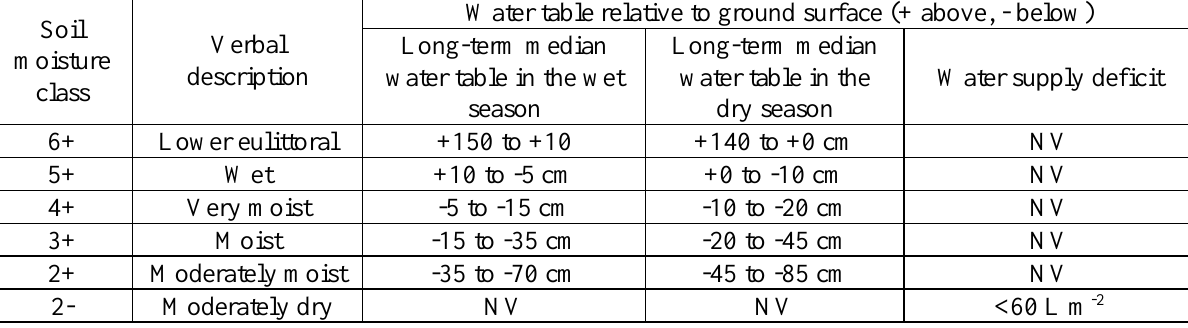
Table 6. Soil moisture classes and associated water tables for peatlands (Joosten et al. 2015 after Koska 2001). NV = no